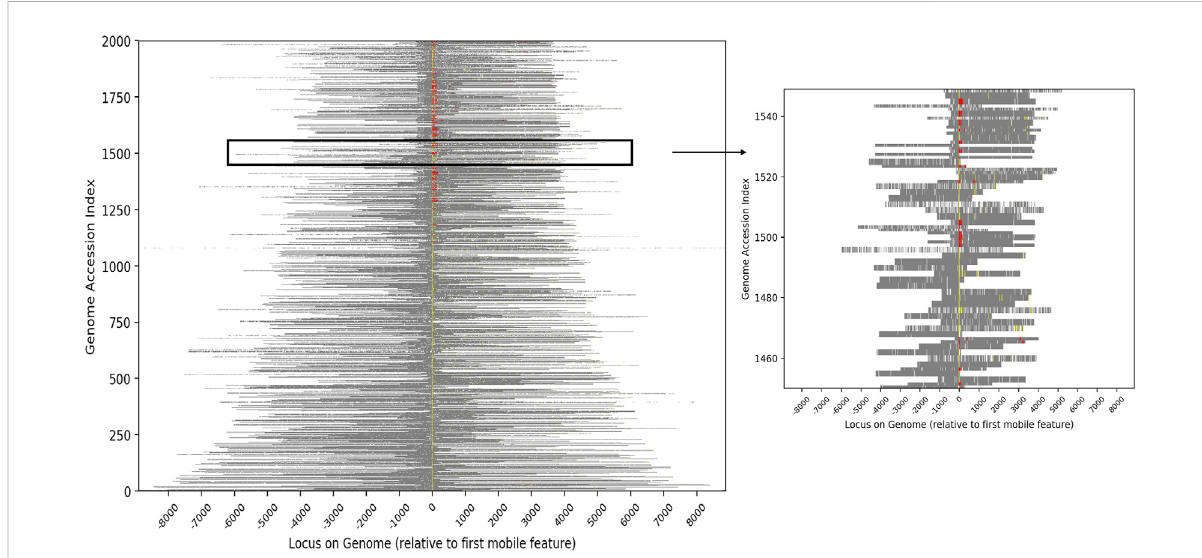
FIGURE 2 Heatmap showing the relative genomic positions of conjugative features and putative cargo proteins for the 2,000 genomes with the greatest number of cargo proteins. Conjugative features are represented as color pixels based on the colors shown in Table 1, with yellow representing proteins assigned speci fi c IPR codes and red representing protein families from the literature. Cargo proteins are shown in grey and other chromosomal DNA in white. Each genome is bit shifted to the left until the fi rst conjugative feature is centered in the fi gure. Most genomes contained more than one conjugative protein (all contain at least one). The inset highlights the genomes at indices 1450 – 1550 in order to expand a subset of the